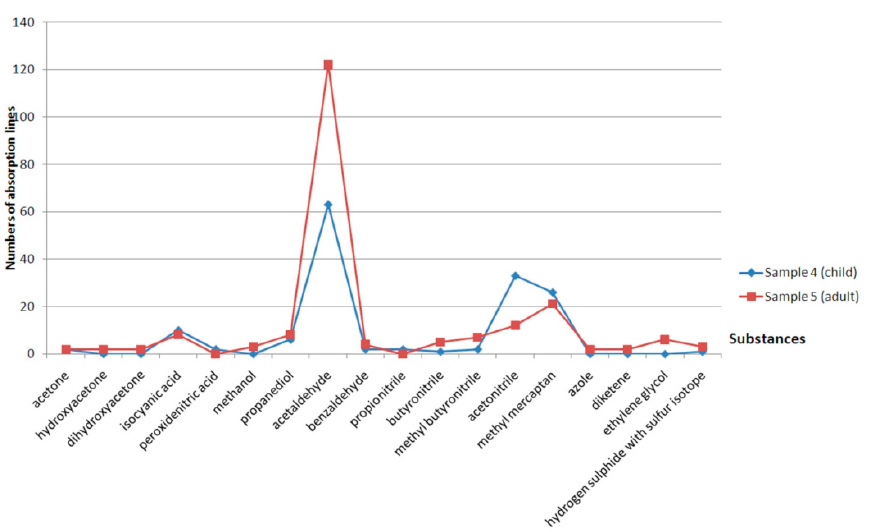
Figure 7. The chemical composition of the products of thermal decomposition of polyp samples taken from a child (Sample 4) and an adult (Sample 5).